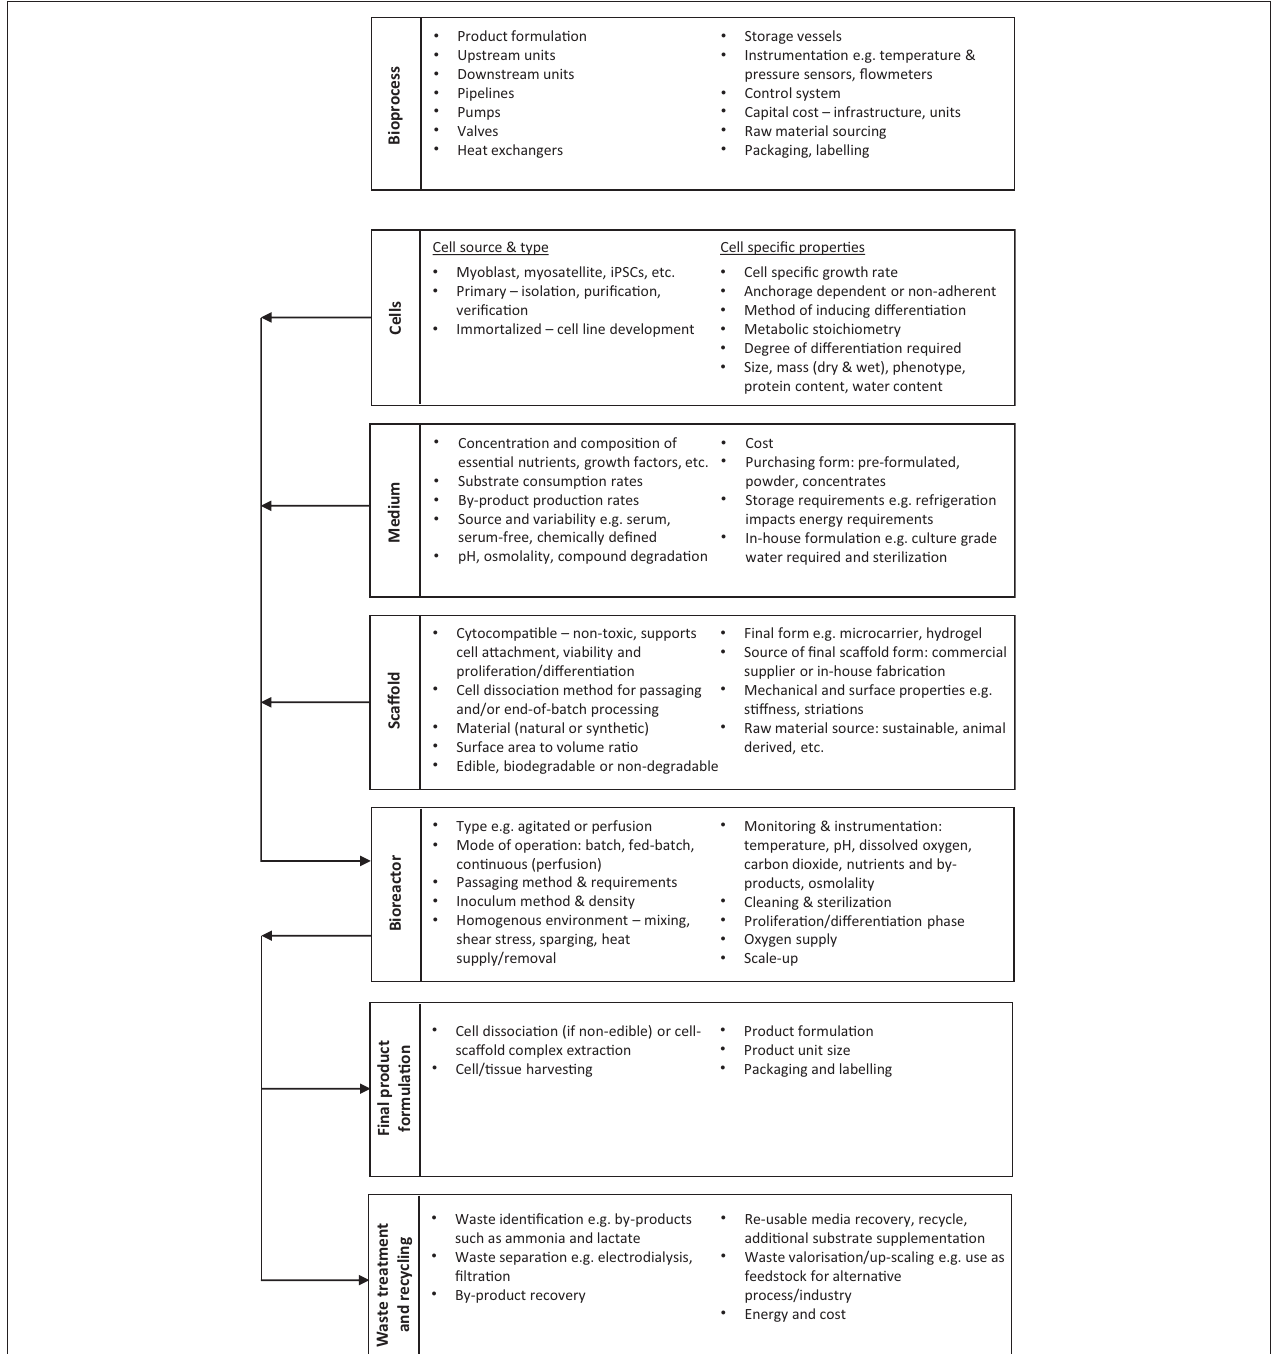
FIGURE 1 | Summary of the key areas of consideration for cultured meat bioprocess design. The top block gives a whole-process overview, and the remaining boxes provide a summary of the inputs to and outputs from the bioreactor.